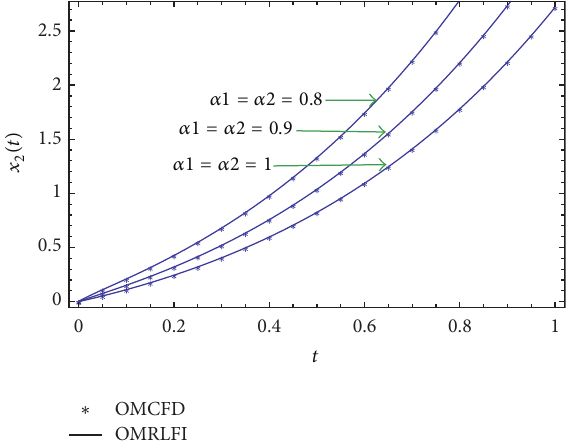
Figure 6: Approximate solutions of 𝑥 2 (𝑡) for 𝑚 = 10 and different values of 𝛼 1 , 𝛼 2 by OMCFD and OMRLFI in Example 13.